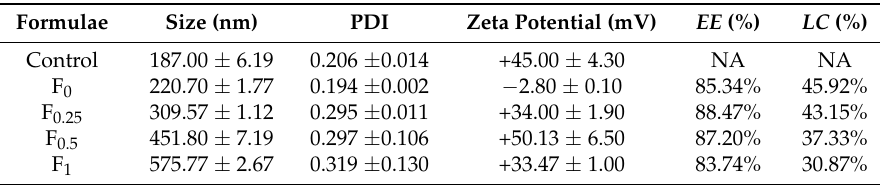
Table 2. Effects of different LMWC concentrations in the aqueous phase during the creation of PLGA